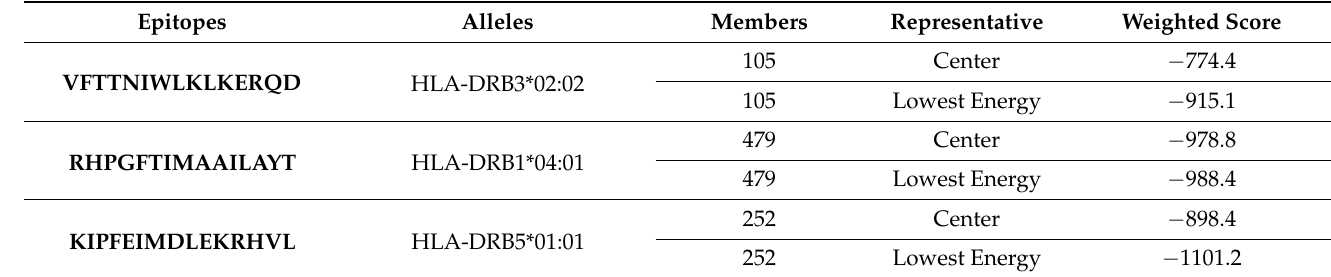
Table 6. Docking of selected HTL epitopes with their corresponding MHC-II alleles.